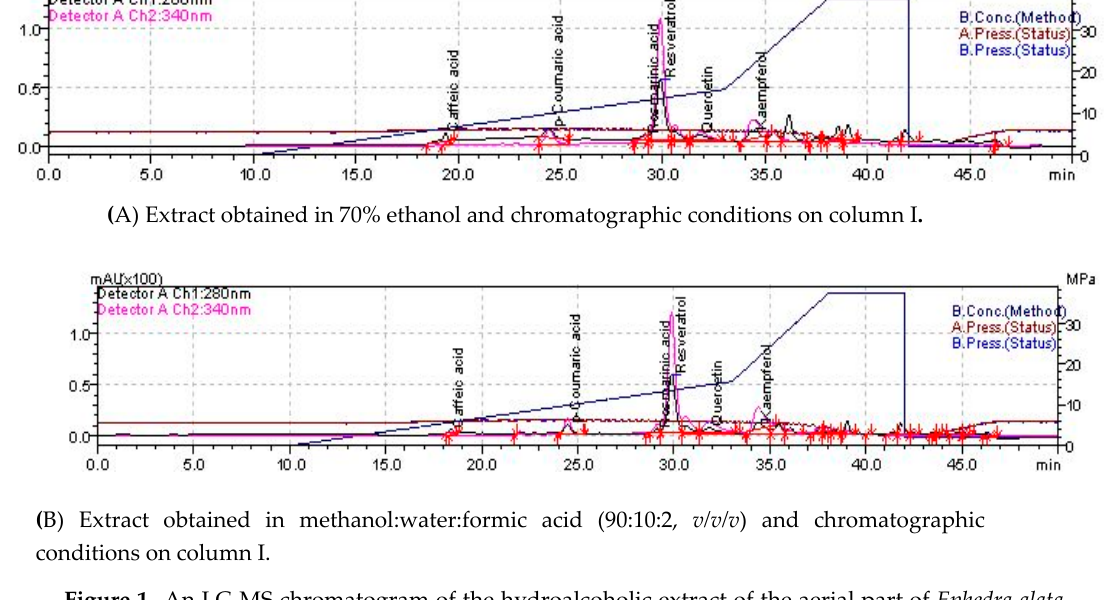
Figure 1. An LC-MS chromatogram of the hydroalcoholic extract of the aerial part of Ephedra alata Decne. (EA).